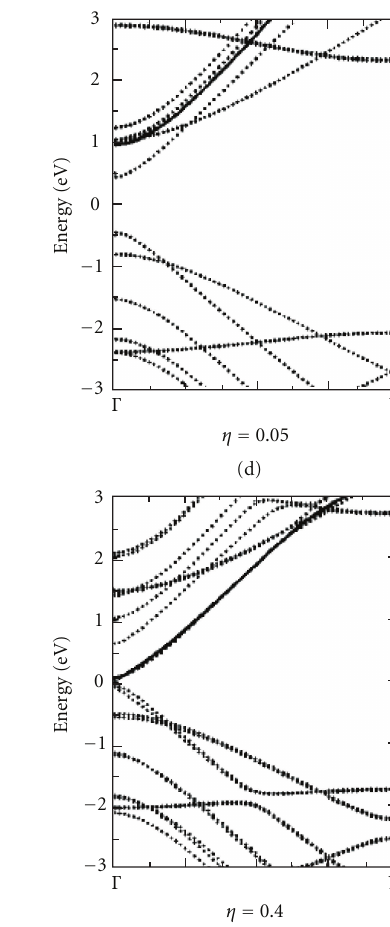
on a substrate, induces a semiconductor-metal